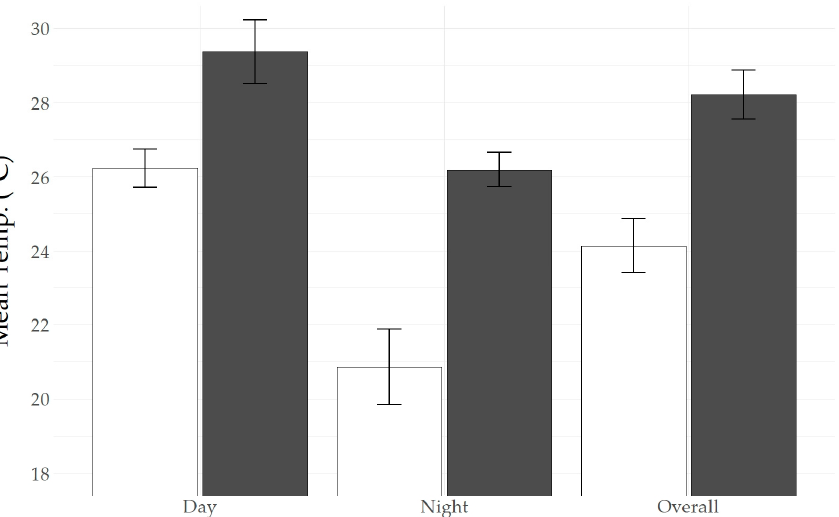
Figure 3. Measurements of ambient temperature (white) and roost tree temperature (black) for roosts containing temperature-sensitive transmitters dropped by tagged northern long-eared bats